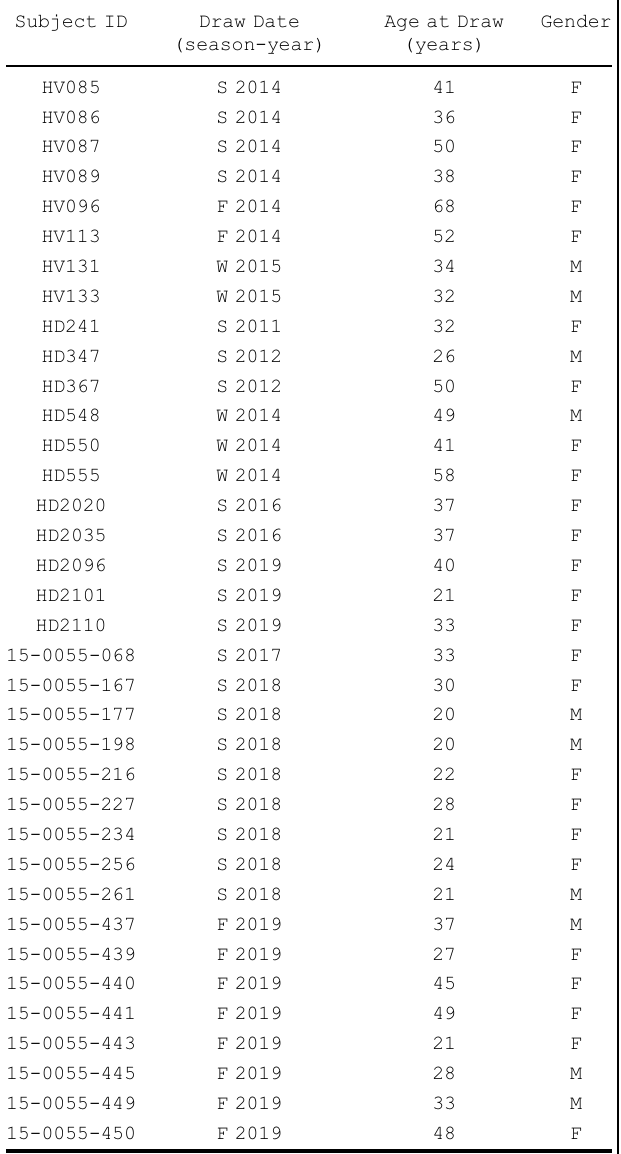
Table 3. Demographics and characteristics of subjects in